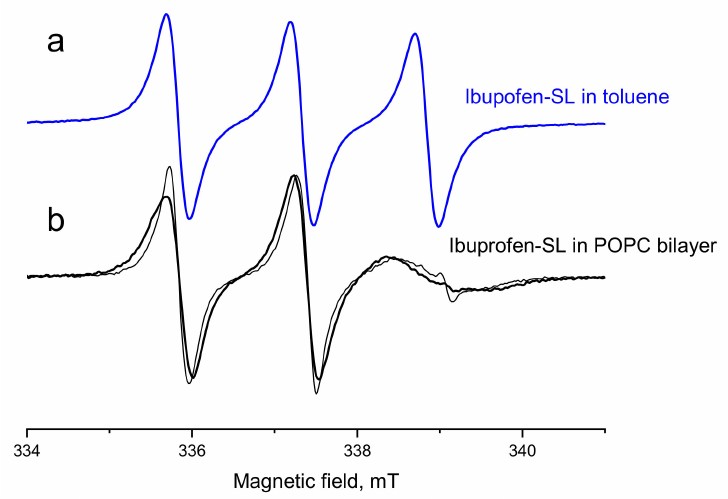
Figure 1. Room-temperature EPR spectra of ibuprofen-SL: for its 1 mM solution in toluene (a), and in presence of POPC bilayers (b). In the latter case, the samples were prepared either by mixing ibuprofen-SL and POPC prior to the bilayer’s preparation (thick line), or by adding the solution of ibuprofen-SL in DMSO to the pure POPC bilayers (thin